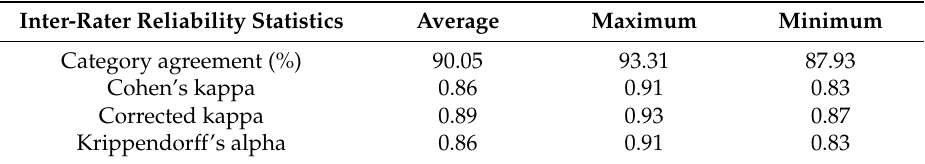
Table 9. Inter-rater reliability statistics for the out-of-lab scenario.